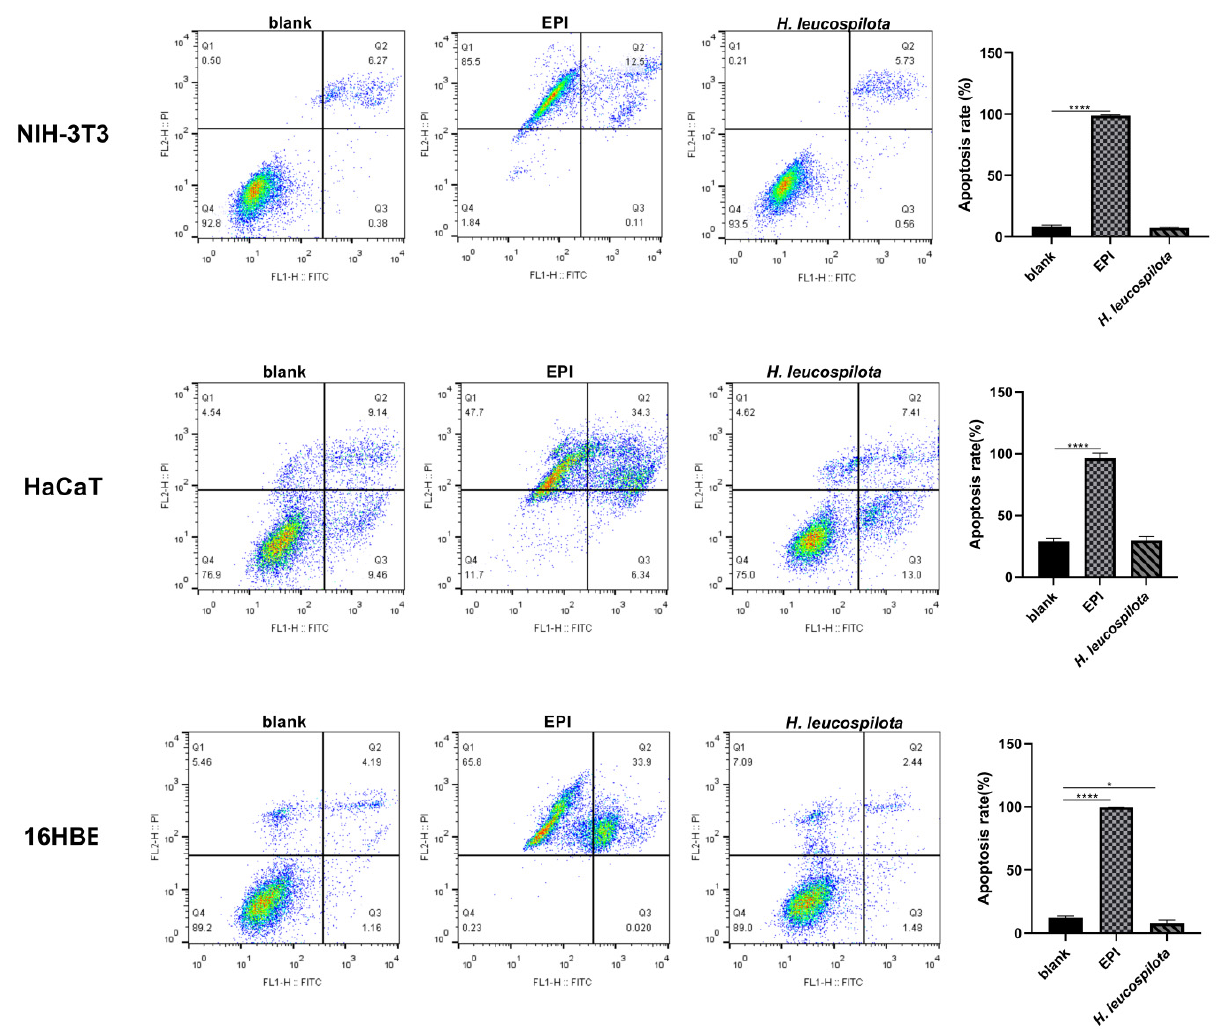
Figure 3. Effect of H. leucospilota protein treatment on cell apoptosis. Cells were treated with the IC 50 concentrations of H. leucospilota protein for 48 h, and EPI (10 μΜ ) as positive group. * p <0.05, *** p <0.001, **** p <0.0001.